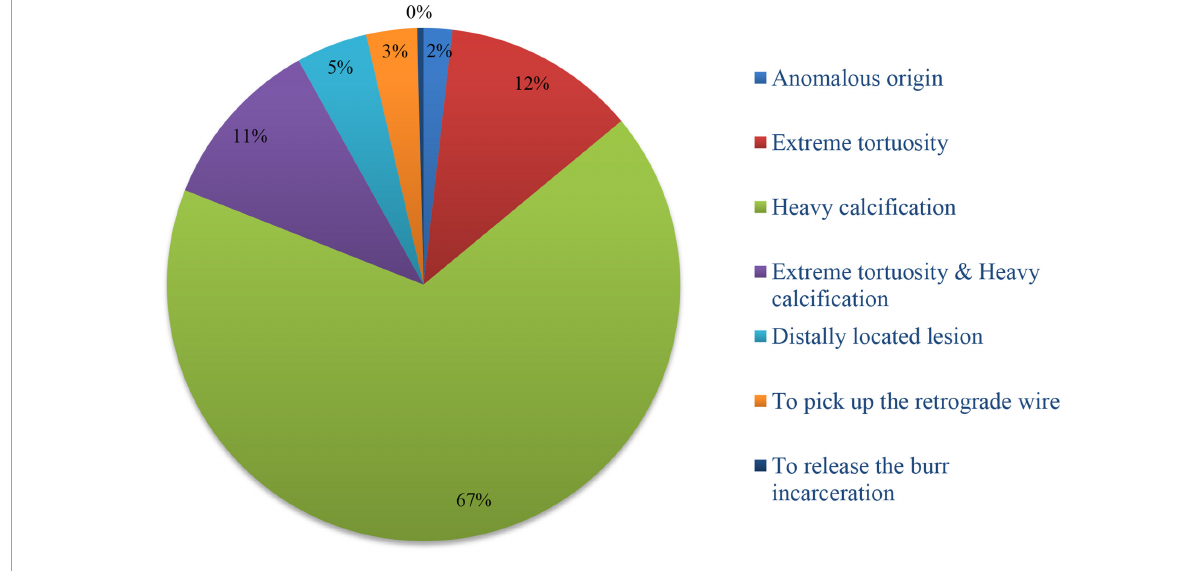
FIGURE2 Indications for GGEC I use in